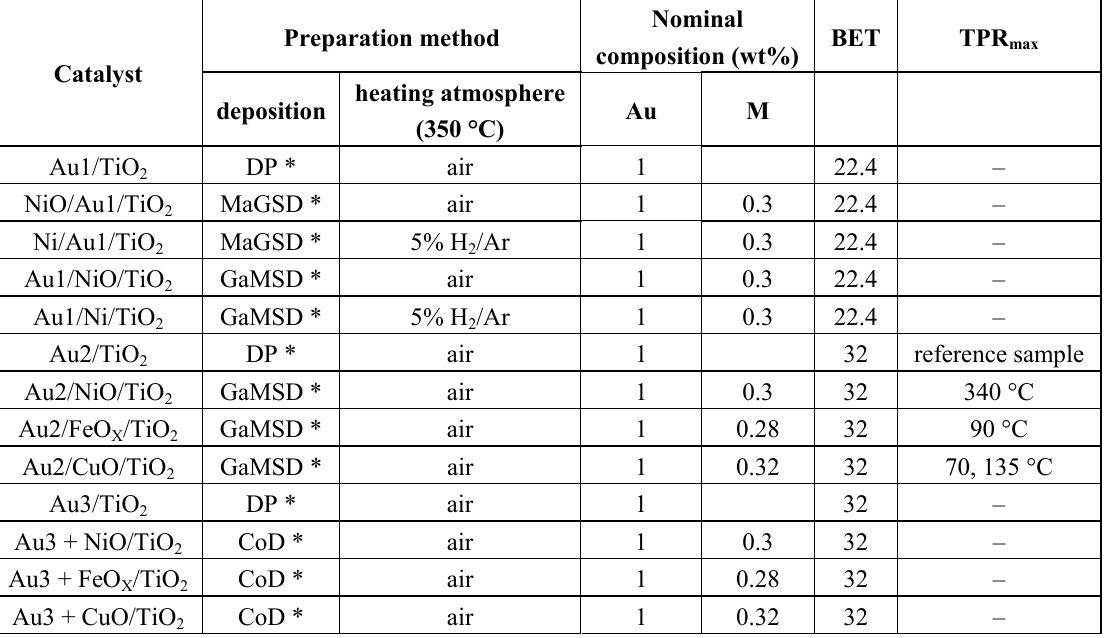
Table 1. Basic properties of the synthesized catalysts.